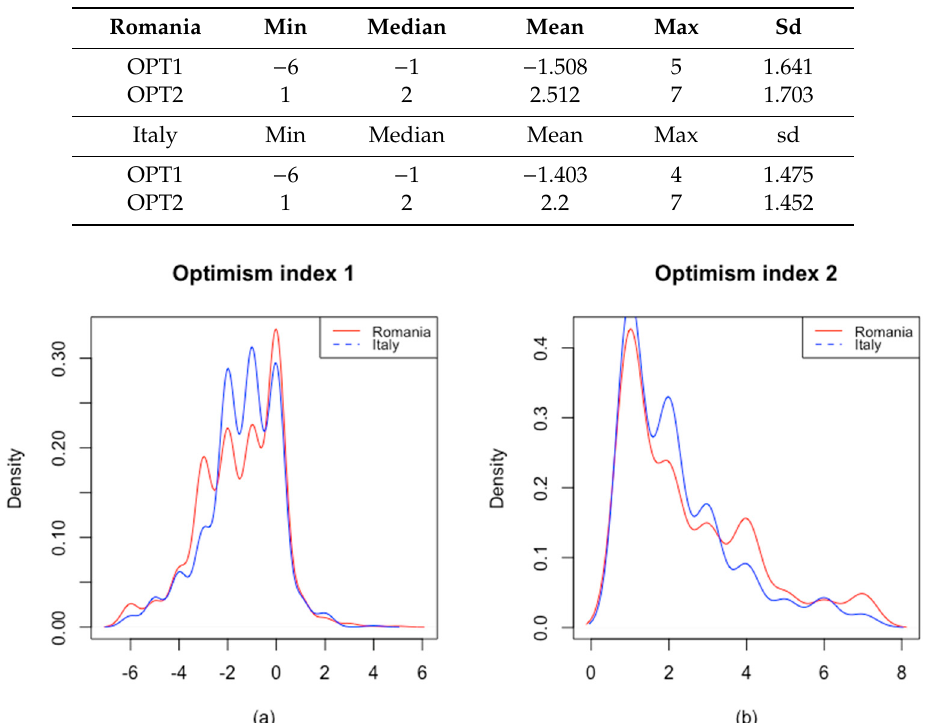
Figure 1. Optimism indices ( a )–indirect measurement, ( b ) direct measurement.